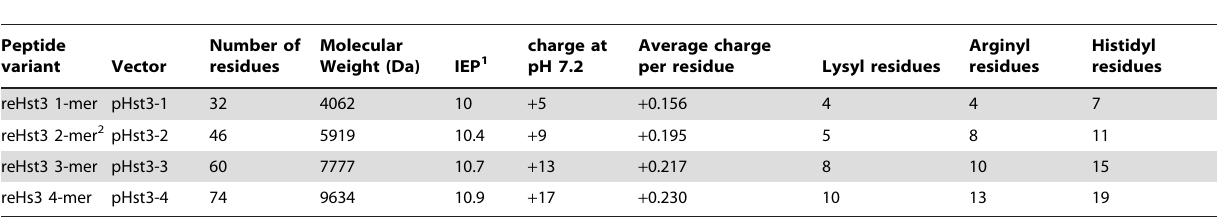
Table 3. Some physico-chemical properties of histatin constructs with multiple functional domains.